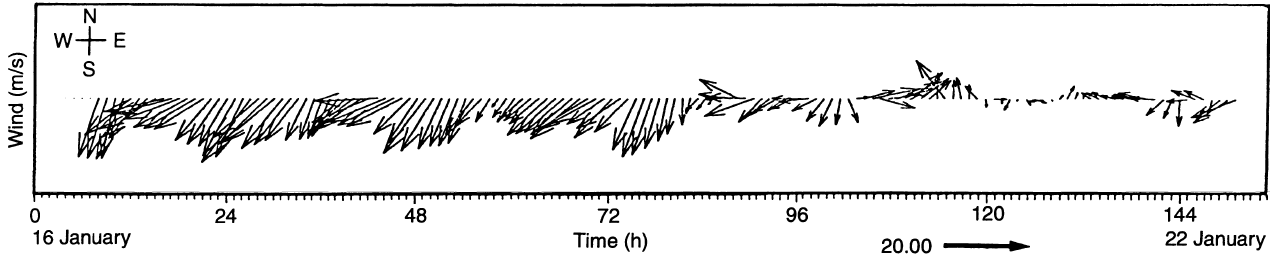
Fig. 3. Diurnal variations of the horizontal surface wind-vector near the coast in Cabo Frio (22 (cid:14) 59 0 S, 42 (cid:14) 02 0 W). Data are from Operation Cabo Frio 8 conducted by the Brazilian Navy in 16–22 January 1986. Units are m s (cid:255)